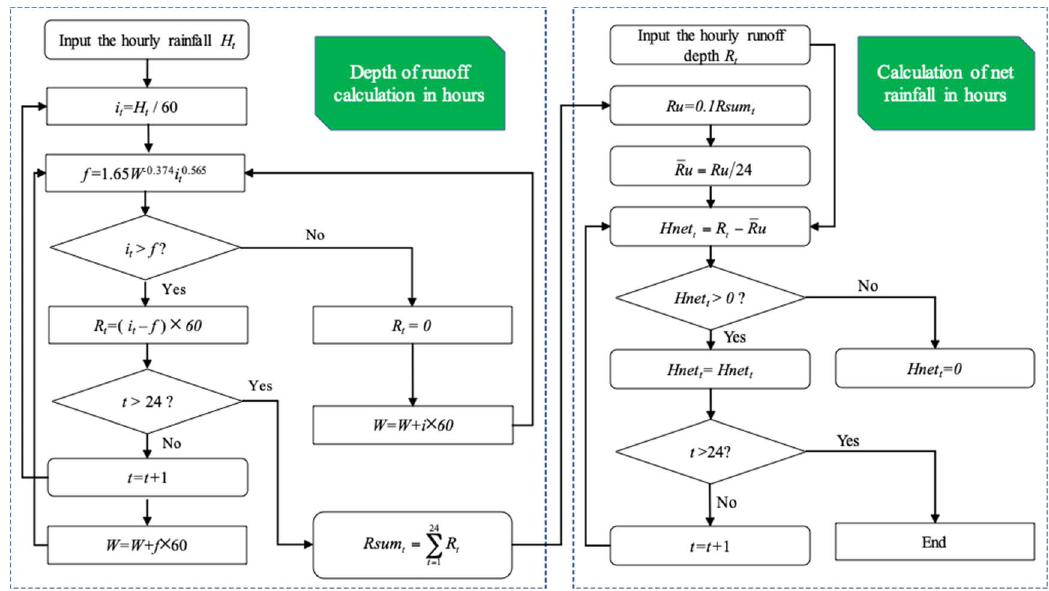
Figure 4. Design net rainfall calculation method, where H t ( t =1, 2,…, 24) represents the hourly rainfall in the design rainfall duration curve; i t ( t =1, 2,…, 24) represents the hourly rainfall intensity, mm/min; f represents the infiltration rate, mm/min; R t ( t =1, 2,…, 24) represents the hourly depth of runoff, mm; W represents the water content of soil and its initial value is 33 mm; Rsum t represents the sum of R t in 24 h, namely daily runoff depth, mm; Ru represents the daily underflow depth, mm; Ru represents the average hourly underflow depth; and Hnet t ( t =1, 2,…, 24) represents the hourly net rainfall.